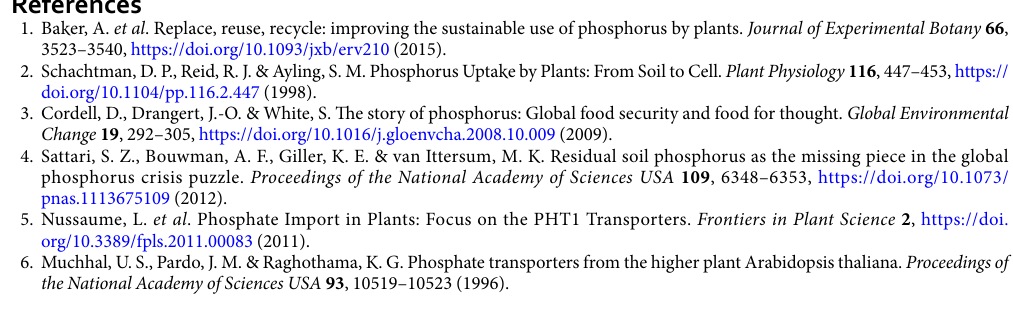
Supplementary Table S3. The PCR products were separated on 10% polyacrylamide gels as described previously 8 . Plant growth experiments and assay of phosphate contents. Inorganic phosphate content was ana- lysed in 4 weeks old seedlings of T1 RNAi lines grown in perlite and supplied with nutrient solution containing 10 µ M Pi 8 . The length of shoot and root and dry weights of root and shoot were determined in these seedlings. In order to dictate the more tightly controlled supply of external Pi, T1 plants of RNAi lines were also grown on hydroponics under 10 and 300 µ M Pi conditions as mentioned in the previous report 8 , total and inorganic P con- tents were assayed using the protocol described by previously 47 . The shoot length, root length, lateral root density and root hair density were analysed in 4 week old seed- lings of T1 RNAi lines grown under low Pi (10 µ M) in hydroponics. In later root density analysis, the roots were scanned using the scanner (HP Scanjet 200). The lateral root density were counted using the scanned images with the help of RootNav software 48 . The root hair density measurements were performed according to 49 with some modifications. About 5 cm from the primary root cap was chosen for root hair analysis. The images were captured with a Leica Stereo Microscope (Wetzlar, Germany). The roots were placed on a stage micrometer with a scale (10 µ m) and observed in Stereo Microscope (10x magnification). The image was then captured with a digital cam- era (Cannon Coolpix, Cannon). The root hair density was counted using ImageJ scientific software 50